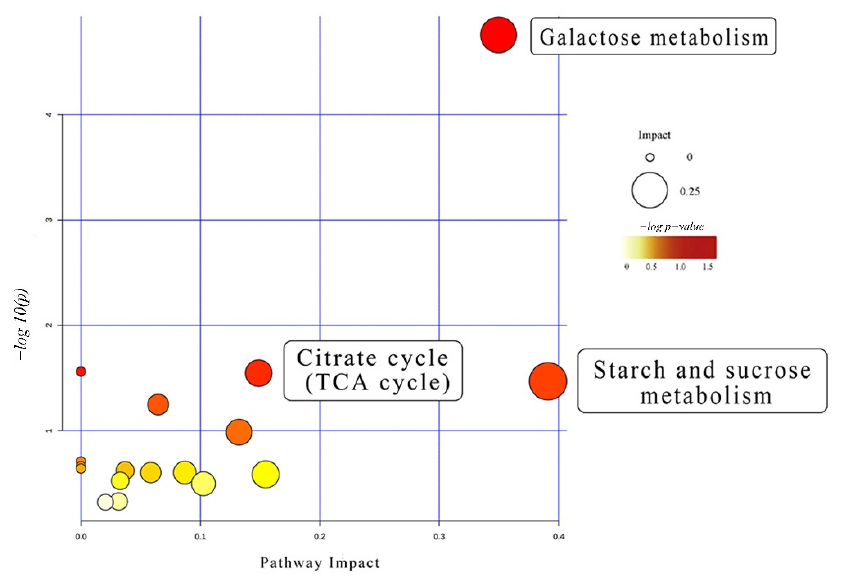
Figure 4. Metabolome map of significant metabolic pathways at different latitudes of T. amurensis. Significantly changed pathways are shown based on enrichment and topology analysis. The x-axis represents pathway enrichment, and the y-axis represents the pathway to impact. The larger size and darker color represent higher pathway enrichment and impact values, respectively.